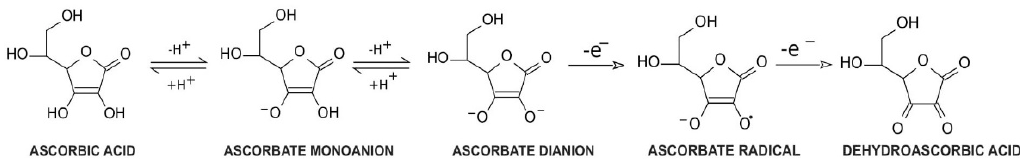
Figure 1. Vitamin C redox states. Ascorbic acid undergoes two reversible hydrogen dissociations to form ascorbate monoanions and ascorbate dianions, respectively. Then, ascorbate dianons can be subsequently subjected to one-electron oxidation to create ascorbate radicals. These are not highly reactive components; however, they can undergo another one-electron oxidation to form dehydroascorbic acid.